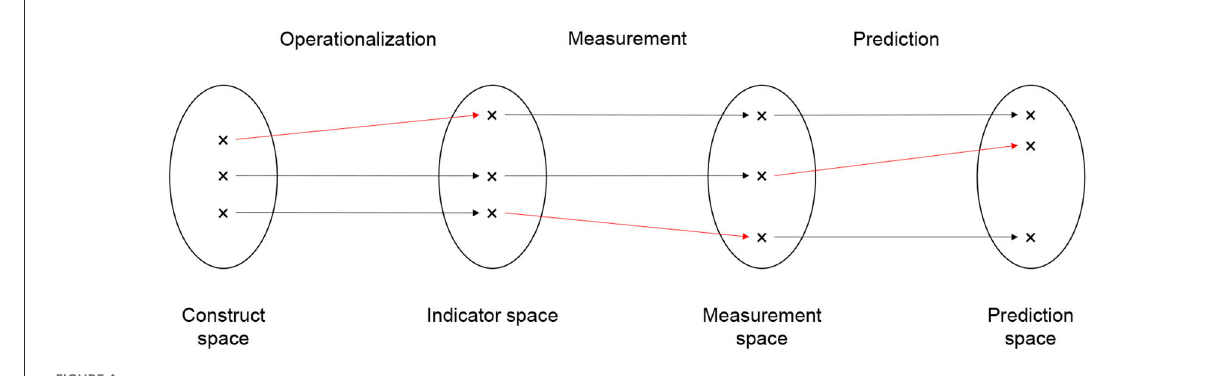
FIGURE4 Spaces and